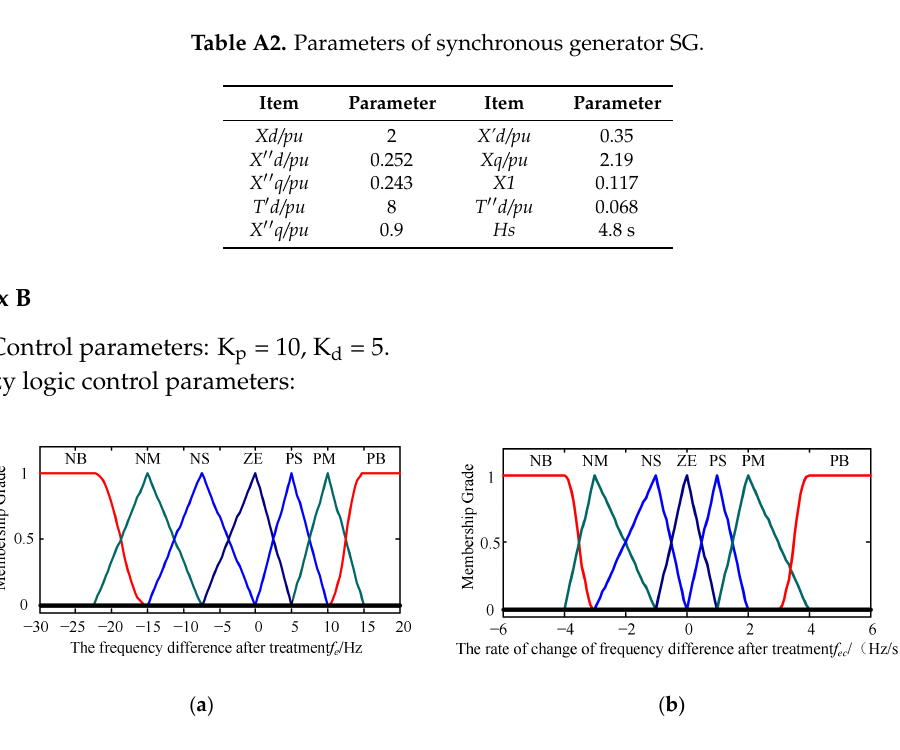
Figure A1. Membership function of input variable: (a) Frequency deviation membership function; (b) Frequency deviation change rate membership function.